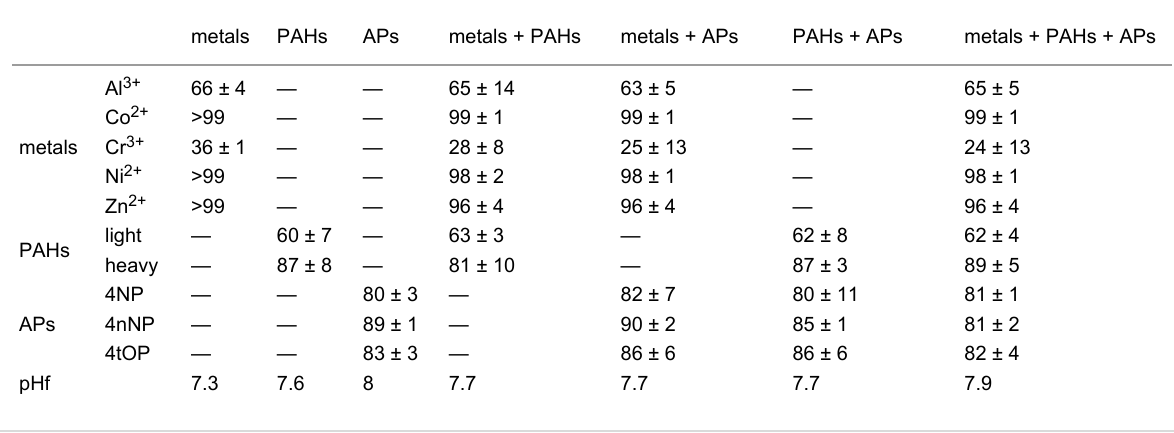
Table 2: Removal efficiency expressed in % of metals, PAHs and APs in solutions containing either one family of substances or mixtures after treat- ment by polyBTCA-CD (concentration = 2 g·L − 1 , n = 3).